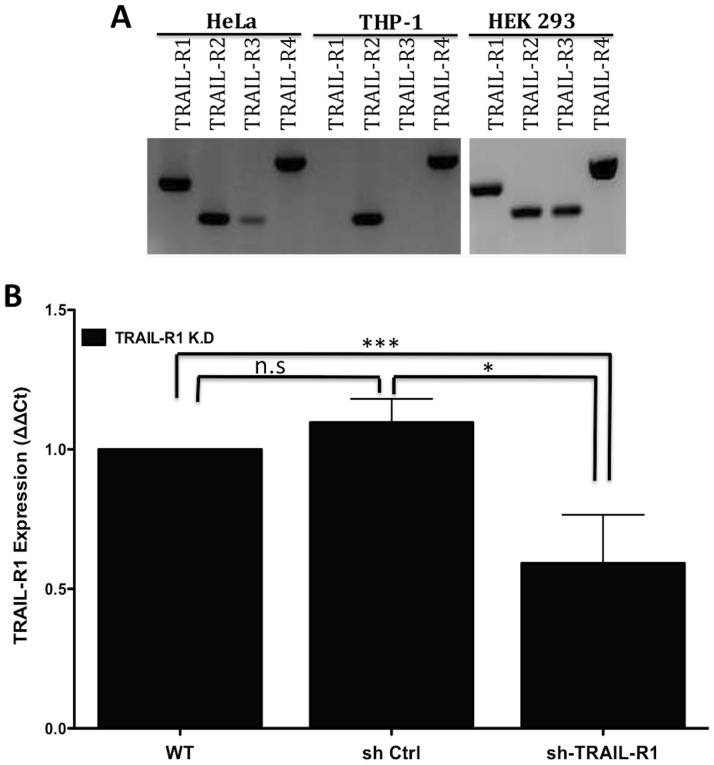
Expression of TRAIL-R1-R4 and depletion of TRAIL-R1 in human cells.(A) A 2% agarose gel electrophoresis gel shows RT-PCR amplification of TRAIL-R1 (214 bp), TRAIL-R2 (145 bp), TRAIL-R3 (141 bp) and TRAIL-R4 (271 bp) mRNA from HeLa, THP-1 and HEK293 cell lines. (B) HeLa cells transduced with TRAIL-R1 specific shRNA (sh-TRAIL-R1) show a reduced level of TRAIL-R1 mRNA when measured by real-time PCR and compared with wildtype (WT) and non-target control (sh Ctrl). Error bars represent standard deviations from at least 3 independent experiments. *** indicates p<0.001 (p = 0.0152) and “n.s” indicates “not significant” (p = 0.1229) compared with WT. The p value for sh-TRAIL-R1 compared to non-target control is 0.0107